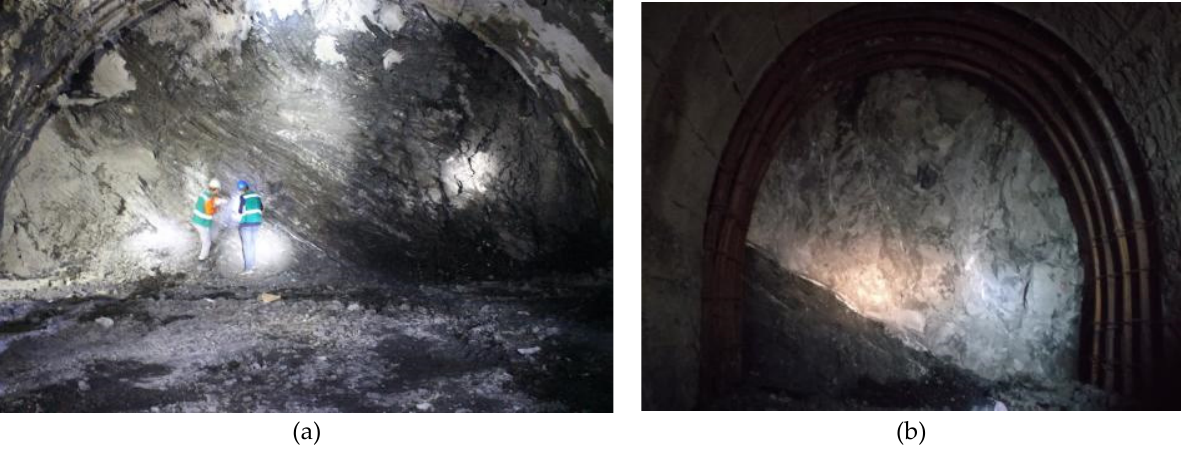
Figure 1. Diagram of the rock around the excavation of the right line of the Yuelongmen Tunnel for section YD2K100+560–630: ( a ) tunnel section YD2K100+565; ( b ) tunnel section YD2K100+610